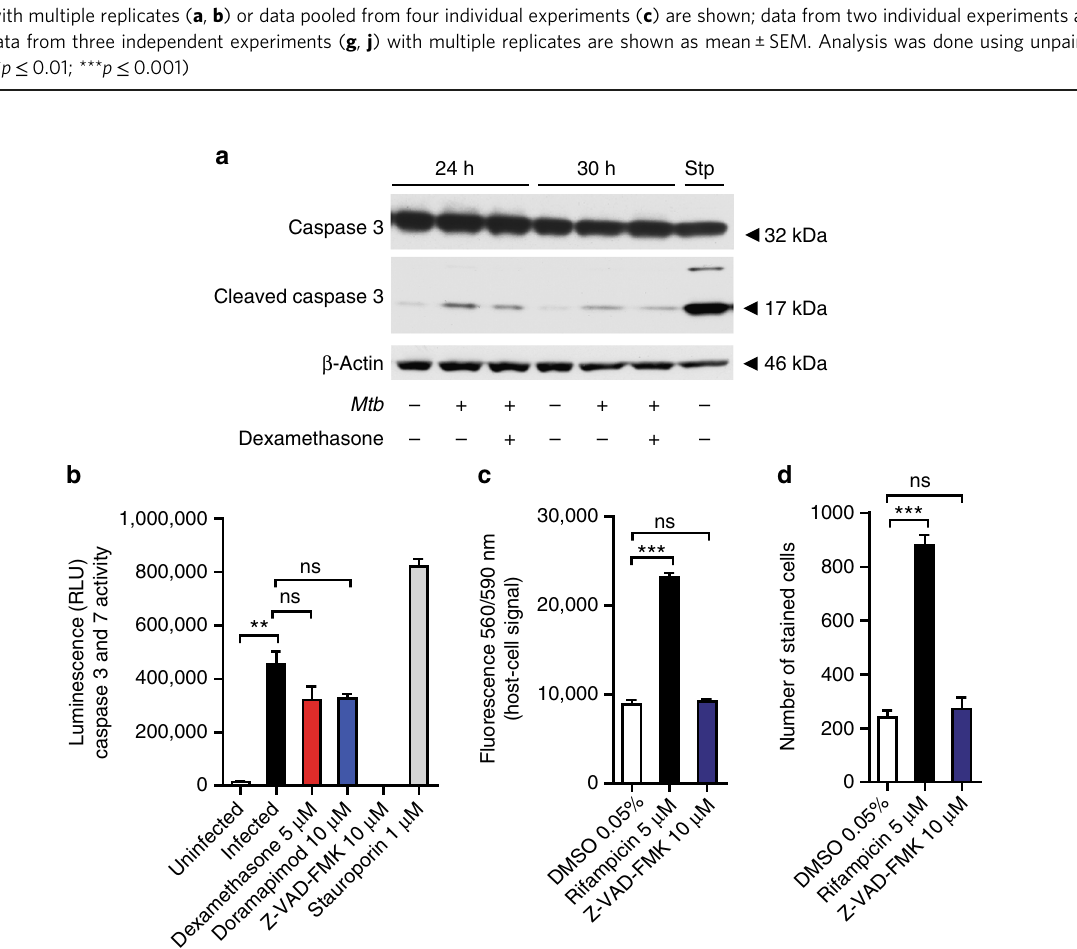
Fig. 2 The protective effect of dexamethasone is mediated by MKP-1 and p38 MAPK inhibition. a Inhibition of MKP-1 by (E/Z)-Bcl hydrochloride or inhibition of the glucocorticoid receptor (GR) by Ru-486 in Mtb- infected MRC-5 lung fi broblasts (MOI 10) abrogates the protective effect